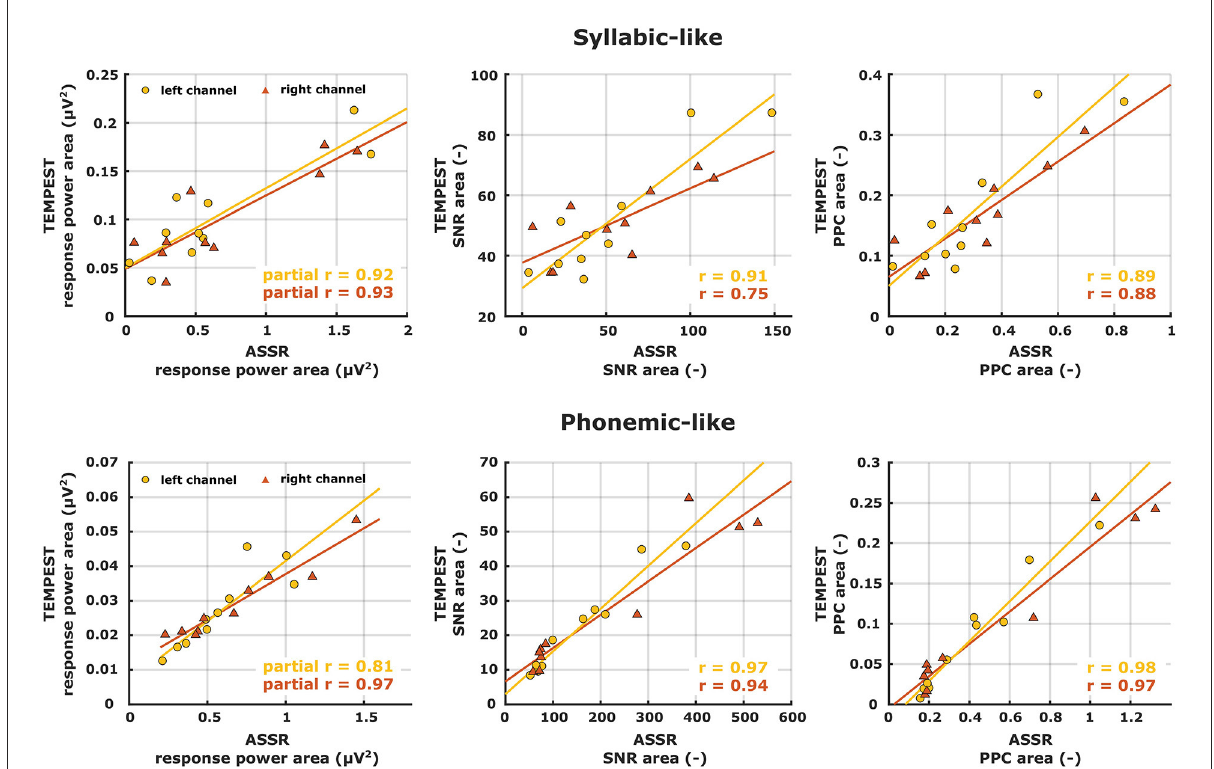
FIGURE9 Correlation scatterplots between ASSR and TEMPEST area under patterns of the same electrophysiological metric for syllabic-like (first row) and phonemic-like (second row) neural responses. Pearson’s partial correlation coefficients are shown only for the power metric whereas Pearson’s correlation coefficients are shown for the other metrics in the right bottom